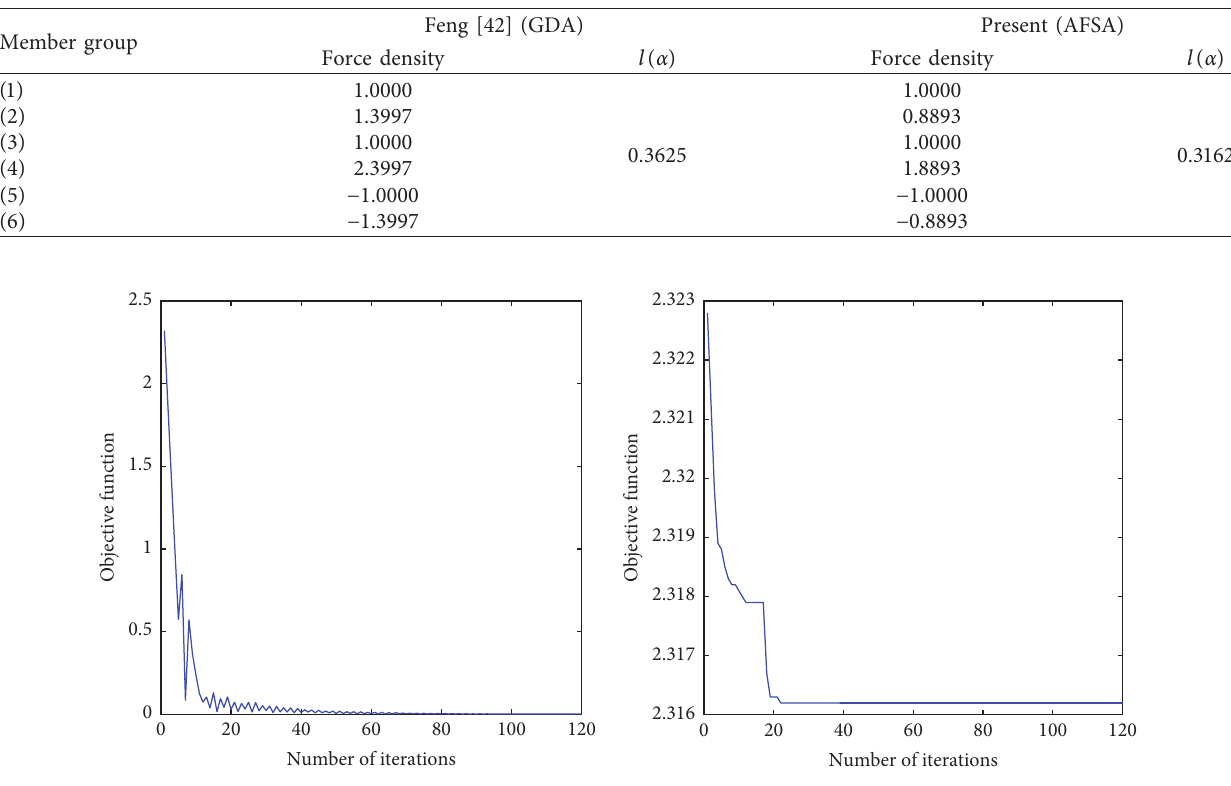
Figure 2: A planar tensegrity grid beam. (a) Initial configuration and (b) member group of force density assumption. Table 1: Optimal prestresses of the planar tensegrity gird.